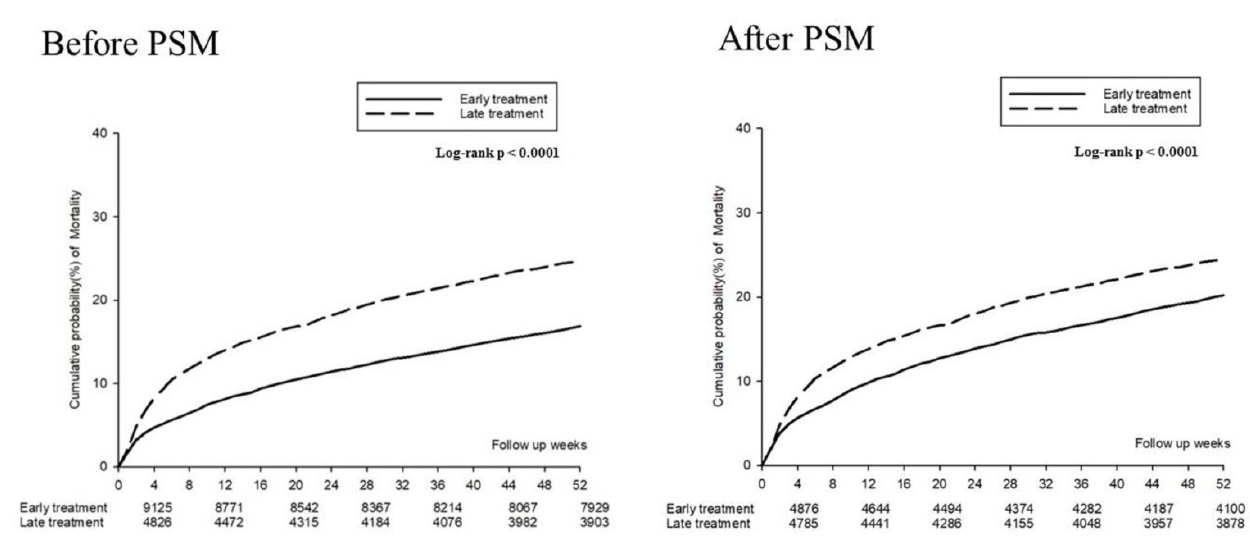
Figure 3. Kaplan–Meier curves for the 52 week mortality risk. Table 2. Multiple Cox regression to estimate the hazard ratio for the 52 week mortality risk.